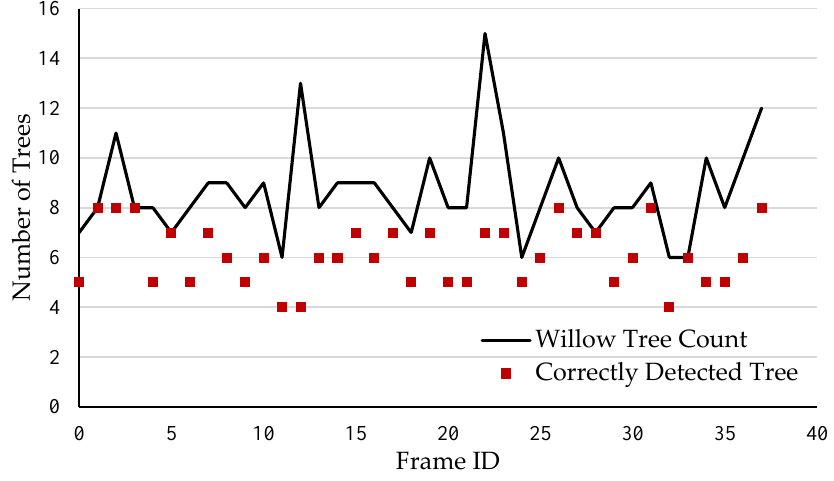
Figure 12. Willow tree yield transect.